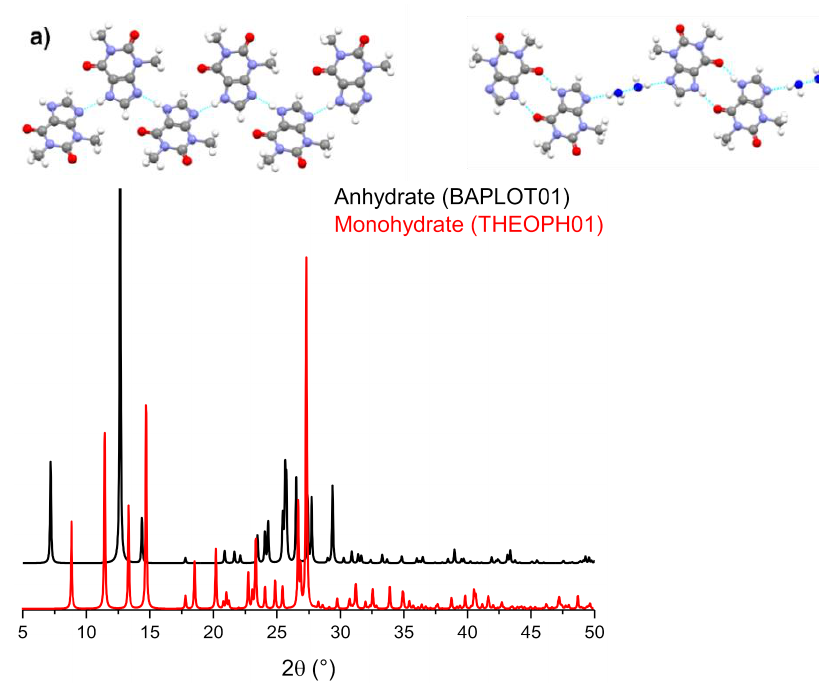
Figure 16. ( Top ): The structures of the anhydrate (( a ), refcode BAPLOT01) and of the monohydrate (( b ), refcode THEOPH01) crystals of theophylline. The anhydrate is obtained from a mixture of an organic solvent and water at low water activity. ( Bottom ): comparison of the the powder diffrac- tograms calculated on the basis of the single-crystal data, showing the difference between the two